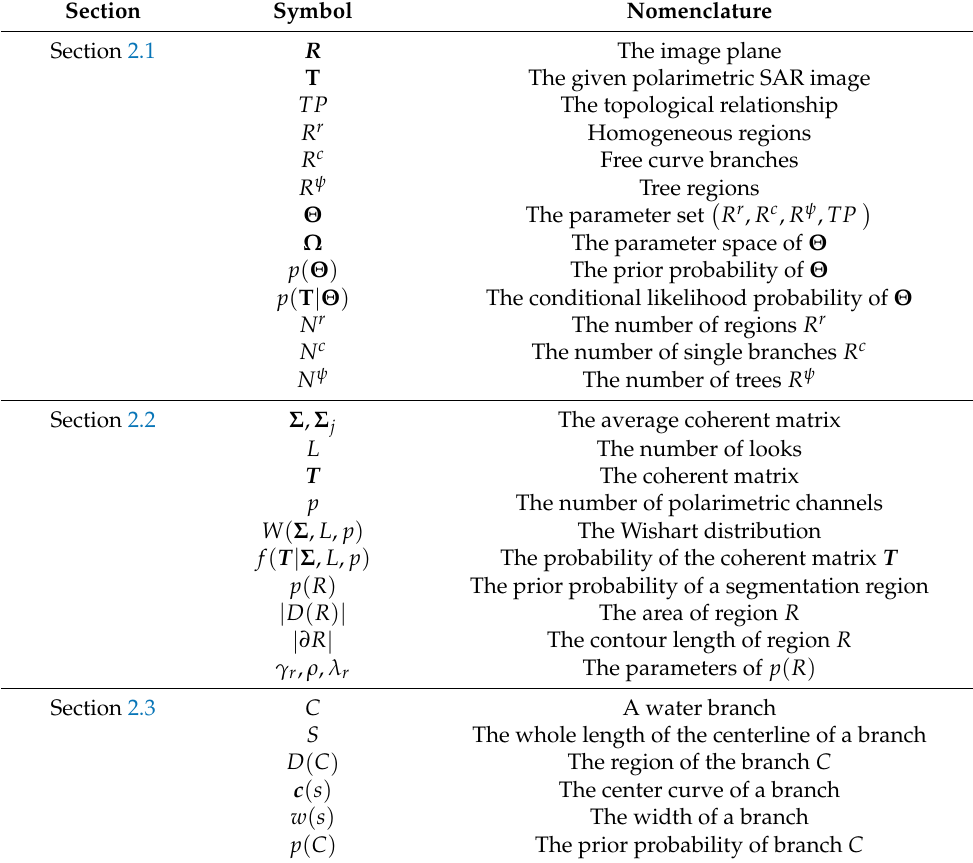
Table A1. The nomenclature of all symbols in each section of the